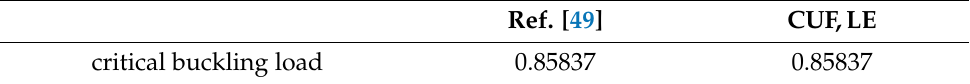
Table 1. The critical buckling load (MN) of the isotropic box beam in the nonlinear (NL) regime.